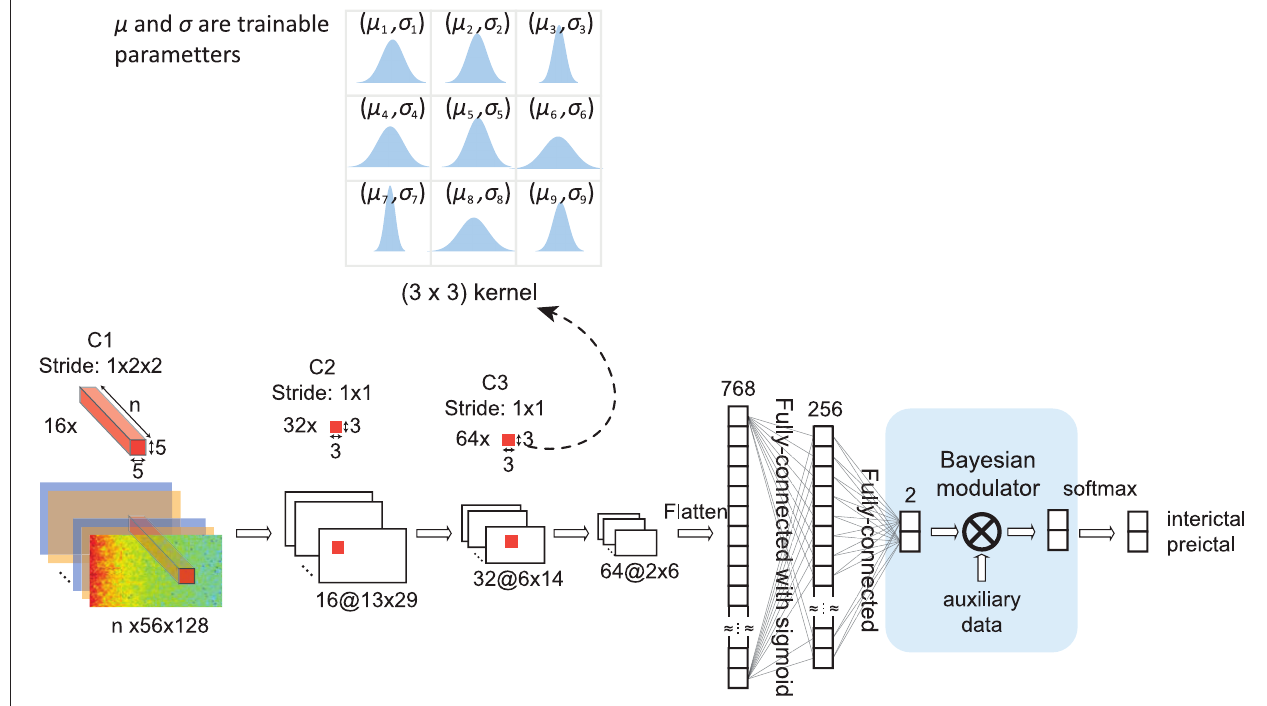
FIGURE 3 | Architecture of Bayesian convolutional neural network (BCNN) with embedded Bayesian modulator. n is the number of EEG channels, which is 19 for all 30 patients in this study. Unlike a conventional convolutional neural network where each weight is a single value, each weight of a BCNN is a distribution. In our work, we model each weight as a normal distribution with mean value ( µ ) and standard deviation ( σ ) are trainable parameters. The BCNN network has three convolutional layers, each is followed by a max-pooling layer (not shown). Extracted features by the convolutional layers are fed to two fully-connected layers. The Bayesian modulator incorporates other relevant data for seizure forecasting into the last fully-connected layer of the network by using Equation